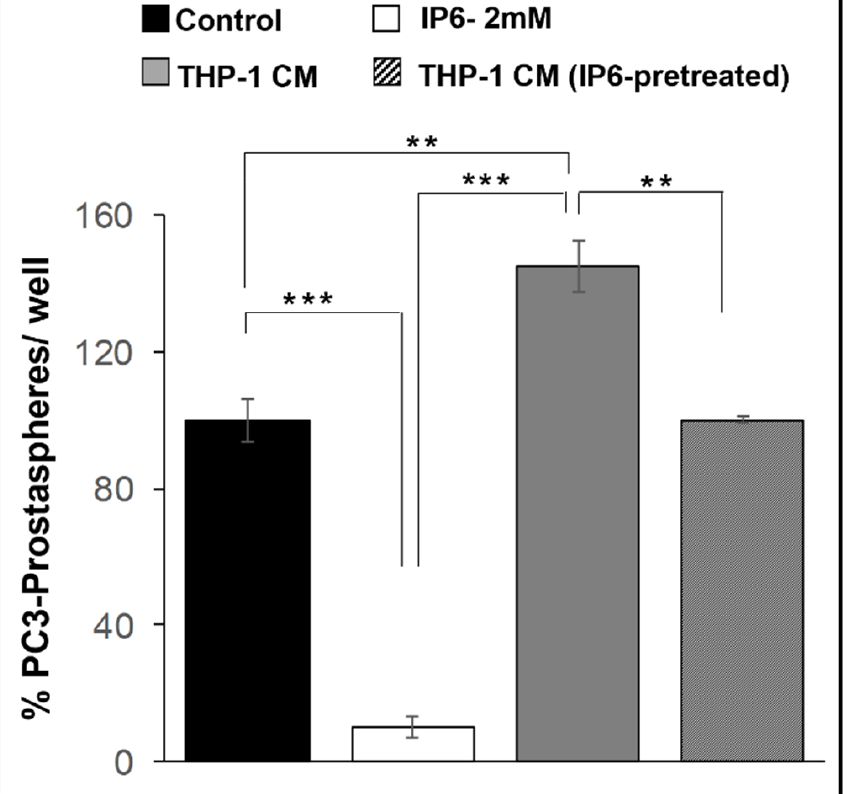
Figure 6. Effect of IP6 treatment on TICs/CSCs enriched prostaspheres in human prostate cancer PC-3 cancer cells. Effect of 2 mM IP6 treatment on TICs/CSCs (CD44 + - α 2 β 1 high ) enriched prostaspheres formation, and effect on prostaspheres formation in the presence of macrophage THP-1 conditioned media and macrophage THP-1 conditioned media (pre-treated with IP6). Quantified data are represented as mean ± SEM. *** p ≤ 0.001 and ** p ≤ 0.01 .